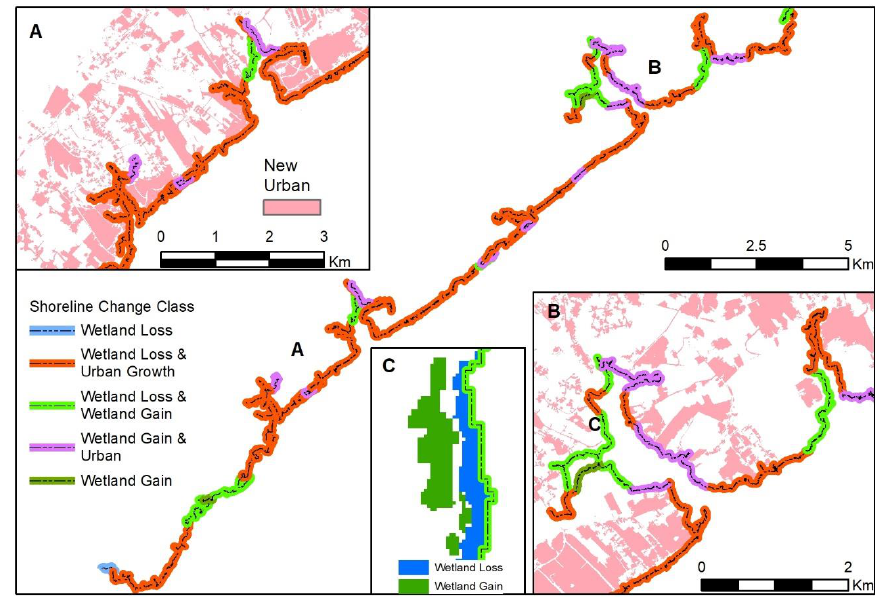
Figure 9. Coastal shoreline classifications where each 1000 m segment was assigned a type of wetland change depending on the adjacent land cover change. The dominant change was wetland loss and urban growth (100 km), but there are smaller areas that had other changes. For example, (A) and (B) are examples of tidal creeks that had a variety of changes including wetland migration, and (C) illustrates a closer look at wetland migration where marsh loss was accompanied with wetland gain on the inland side.